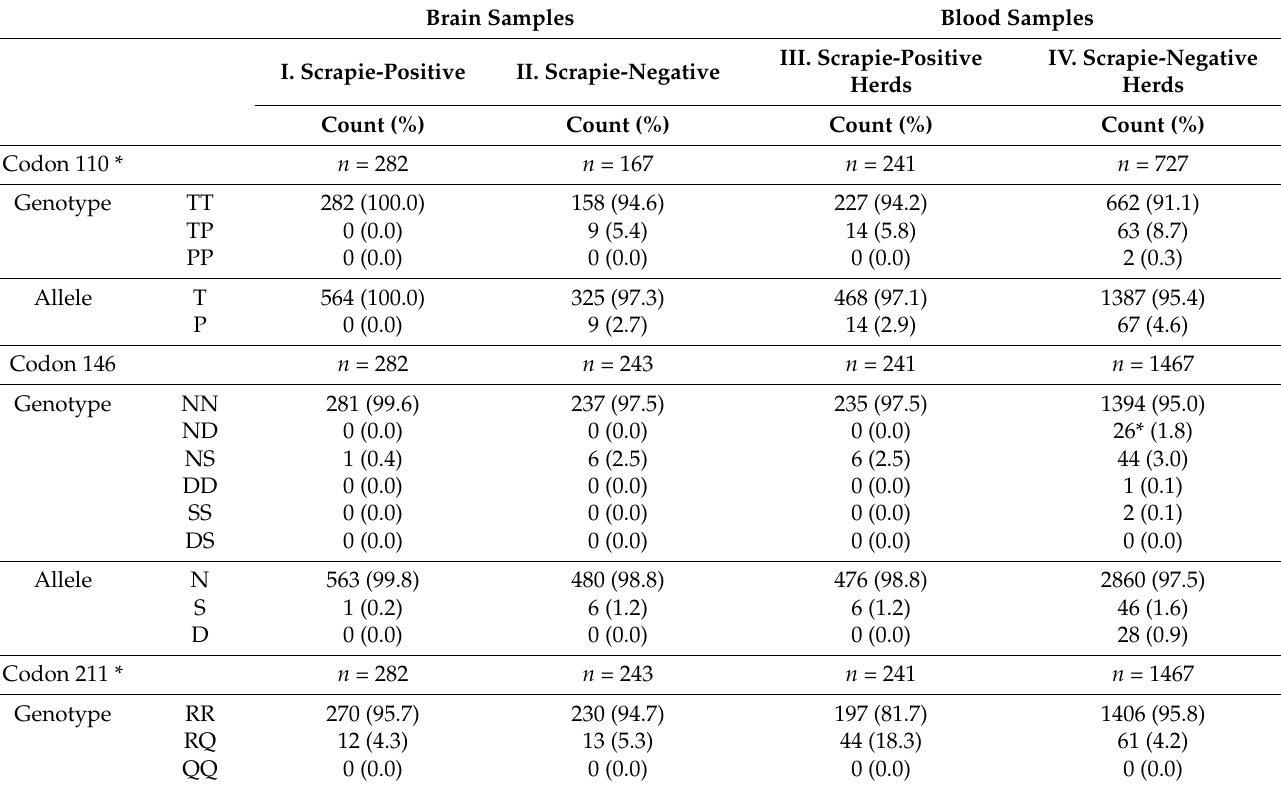
Table 2. Frequencies of genotypes and alleles at codons 110, 146, 211, and 222 for (i) scrapie-positive and scrapie-negative brain samples, and (ii) for goats from scrapie-positive and scrapie-negative